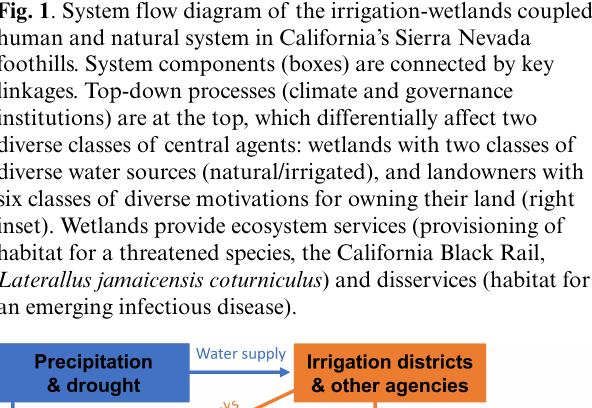
Fig. 1 . System flow diagram of the irrigation-wetlands coupled human and natural system in California’s Sierra Nevada foothills. System components (boxes) are connected by key linkages. Top-down processes (climate and